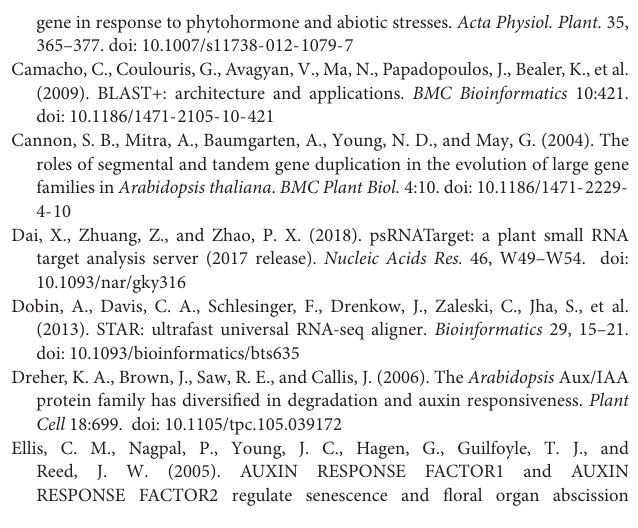
Supplementary Table 2 | Characteristics of ARF genes family in the Salix suchowensis genome v2.0. Supplementary Table 3 | The statistics of duplicated genes in the genomes of nine species. Supplementary Table 4 | The statistics of Ka, Ks, and Ka/Ks values for segmental, tandem, proximal, and transposed duplicated Aux/IAA genes in the genomes of A. thaliana , P. trichocarpa , S. suchowensis , V. vinifera , O. sativa , A. trichopoda , S. moellendorffii , and P. patens . Supplementary Table 5 | The statistics of Ka, Ks, and Ka/Ks values for segmental, tandem, proximal, and transposed duplicated ARF genes in the genomes of A. thaliana , P. trichocarpa , S. suchowensis , V. vinifera , O. sativa , A. trichopoda , S. moellendorffii , and P. patens . Supplementary Table 6 | The time-sequential transcriptome profiles of SuIAAs and SuARFs in the cambium tissues of two contrasting clones “S328” and